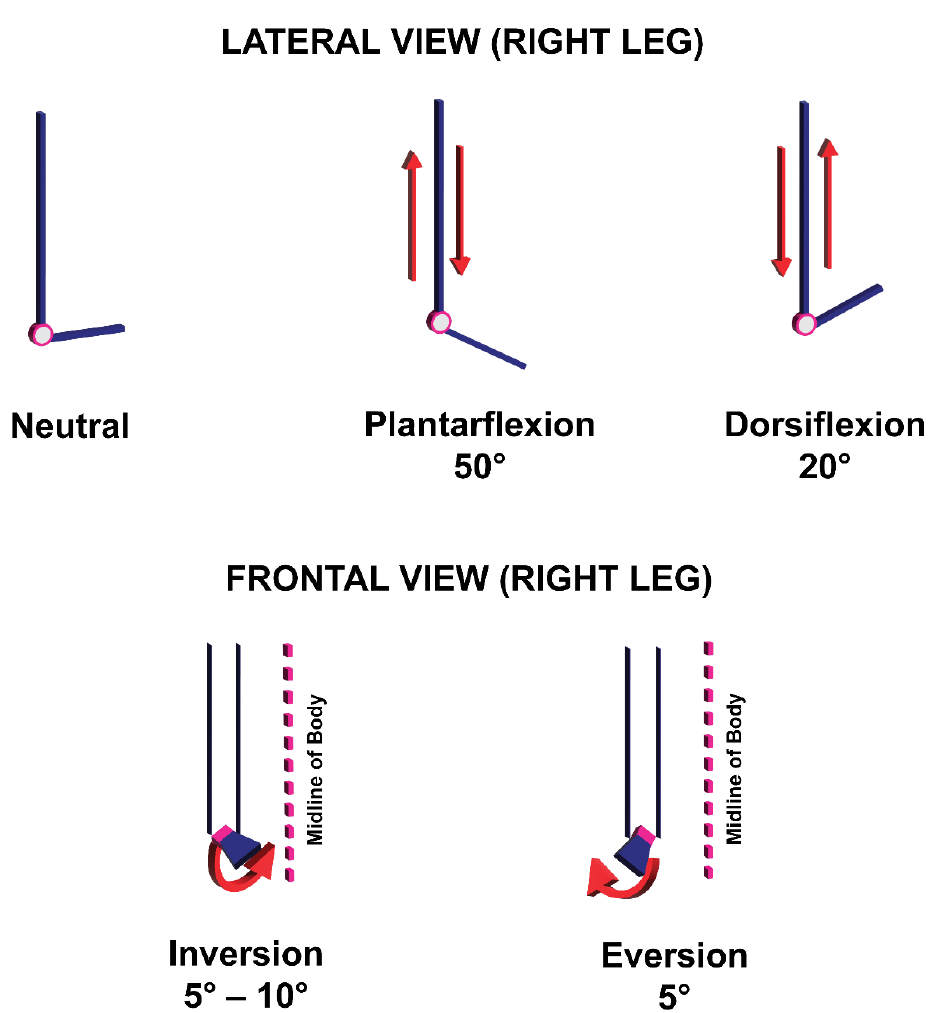
Figure 2. Maximum angles for movements produced by the human ankle